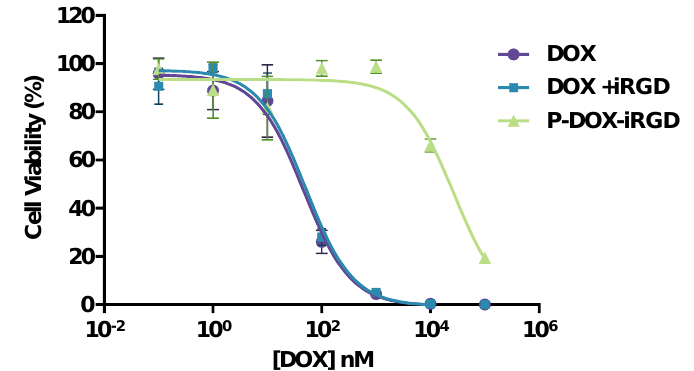
Figure 3. Cytotoxicity of the formulations in 4T1 cells .